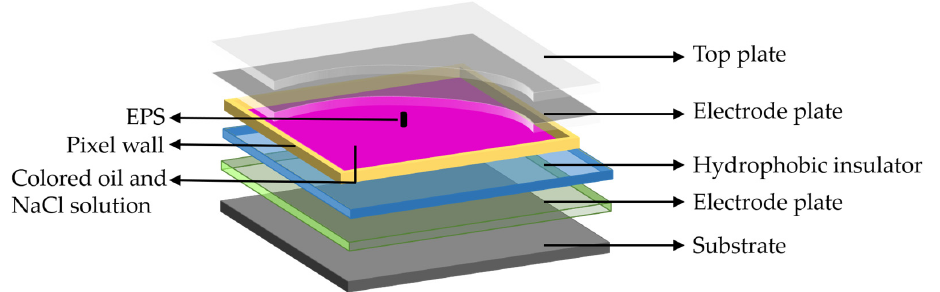
Figure 1. Three-dimensional structure diagram of one pixel in EWD. Each pixel consists of a top plate, a substrate, two electrode plates, colored oil, NaCl aqueous solution, an insulator layer, pixel walls and an EPS.